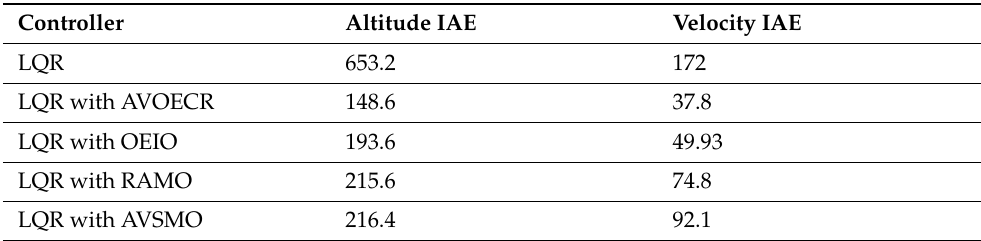
Table 4. IAE comparison of the observer-based disturbance rejection controllers based on LQR for the climb-cruise-land flight profile.